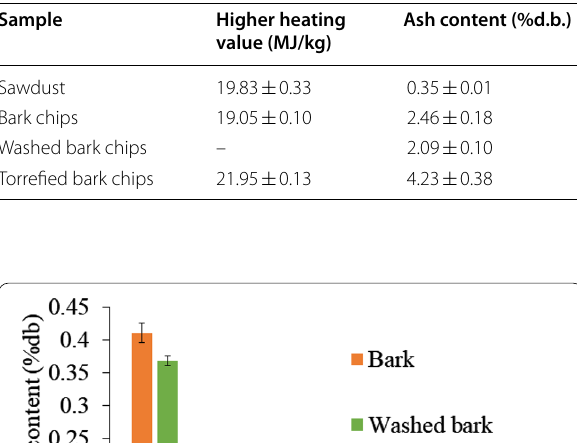
Table 1 Characteristics of each sample